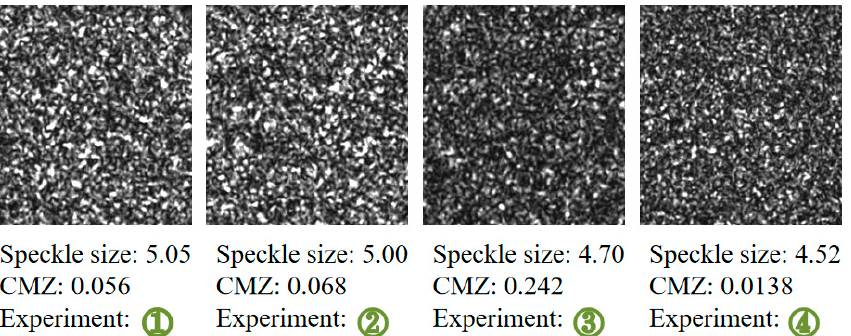
Figure 15. Four speckle patterns from the different experiments, their speckle sizes, and their CMZ values.